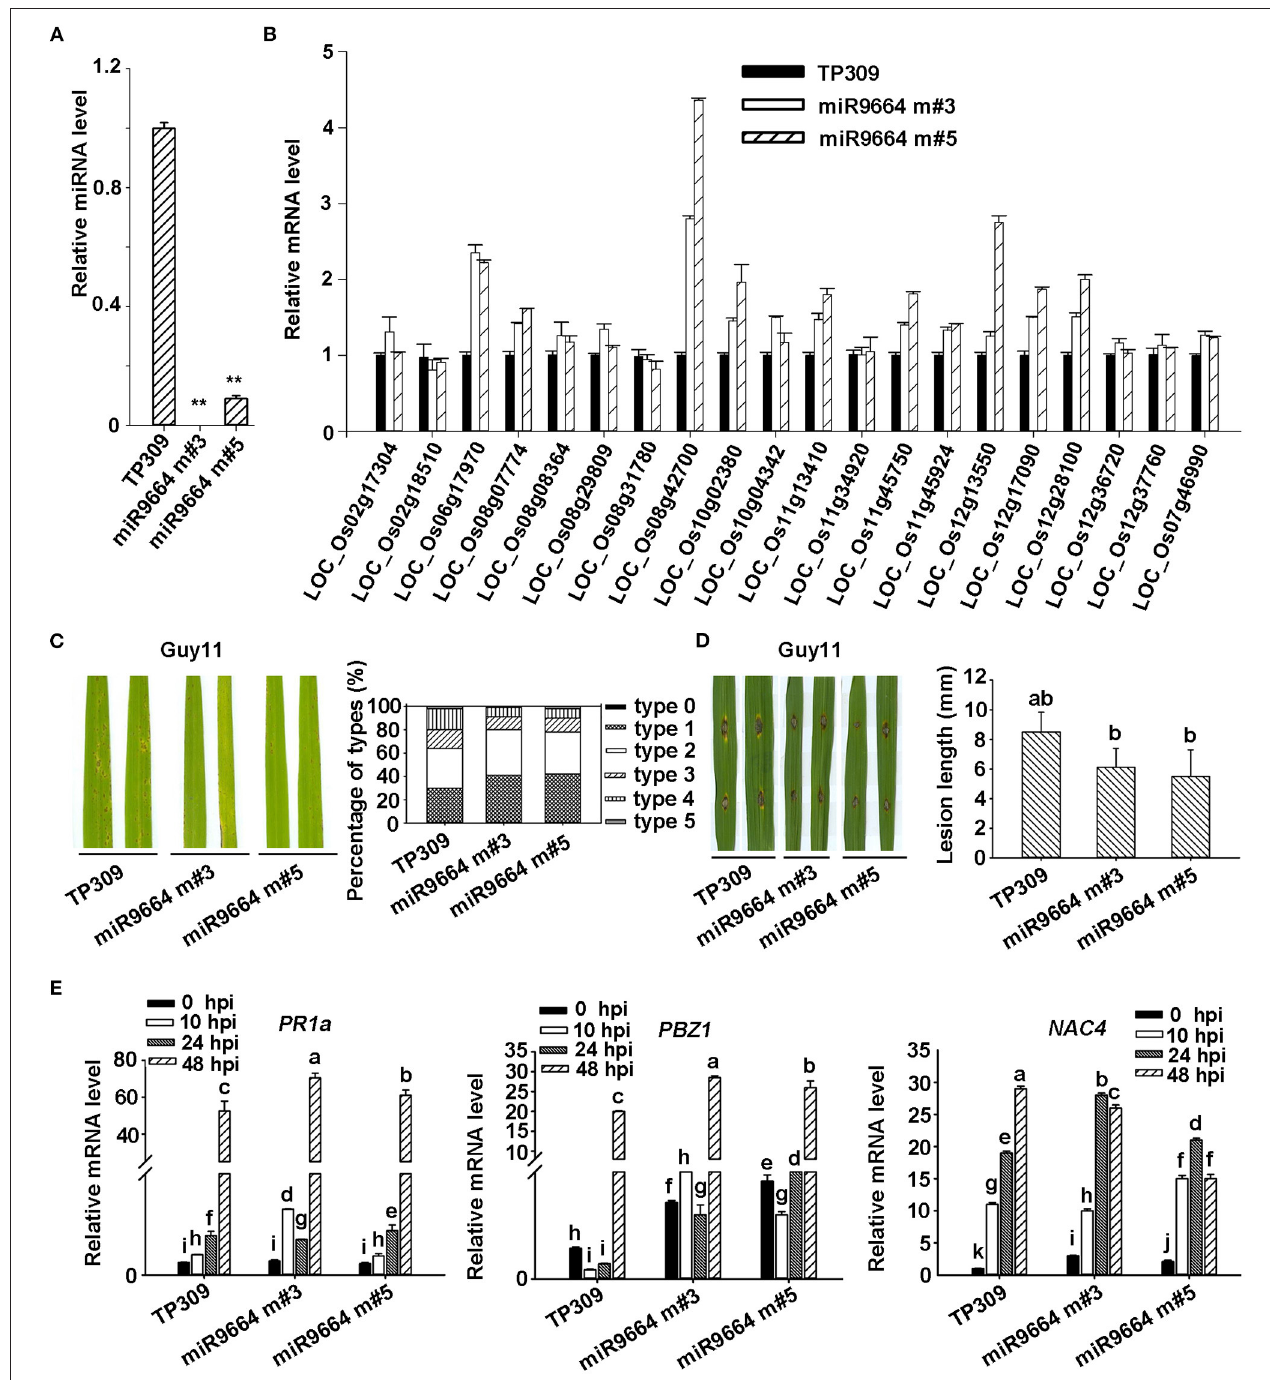
FIGURE 6 | miR9664-m plants enhance resistance to M. oryzae GUY11. (A) The relative expression level of miR9664 in two miR9664-m lines. The ** above the bars indicate significant differences ( P < 0.01). (B) The RNA expression level of 19 miR9664 predicted target genes in the two miR9664-oe lines, the non-target gene LOC_Os07g46990 was used as a control, qRT-PCR results were normalized with the Ubi reference gene. Similar results were obtained from the three independent biological experiments. (C) The blast resistance of miR9664-m plants using spraying inoculation. Two inoculated leaves of each TP309, miR9664 m#3, and miR9664 m#5 are shown. The lesion types were obtained from the statistics of 80 diseased leaves at 5 dpi. (D) The blast resistance of miR9664-m plants using punching inoculation. Two inoculated leaves of each TP309, miR9664 m#3, and miR9664 m#5 are shown. The lesion length was measured using a caliper. Error bars indicate SD ( n = 12), the letters above the bars indicate significant differences ( P < 0.01). (E) RNA expression levels of the defense-related gene PR1a , PBZ1 , and NAC4 in miR9664-m plants, qRT-PCR results were normalized with the Ubi reference gene, the indicated mRNA levels were normalized to those in the untreated control plants (0 hpi). Error bars represent the SD of three replicates ( n = 3). The letters above the bars indicate significant differences at a value of P < 0.01 as determined by a one-way ANOVA followed by a post-hoc Tukey HSD analysis. Similar results were obtained from the three independent biological experiments.